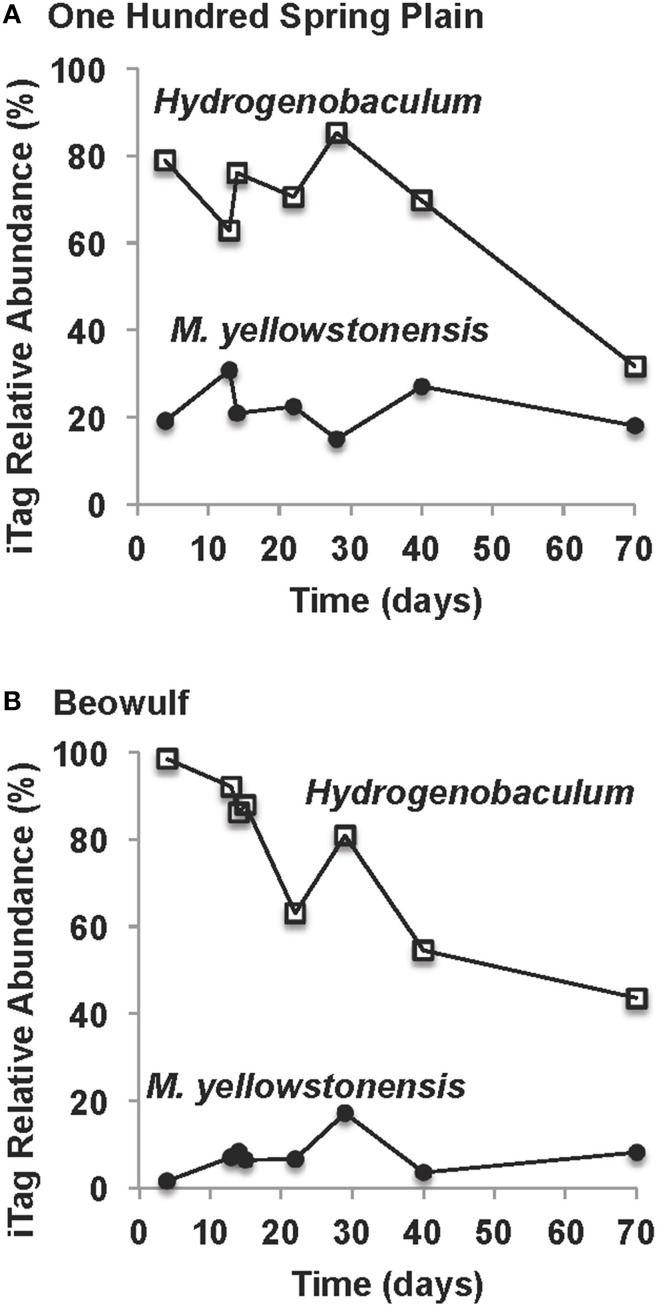
Relative abundance (16S rRNA gene iTags) of key lithoautotrophic microbial populations over the time course of slide incubations in One Hundred Spring Plain (A) and Beowulf (B) Springs (Hydrogenobaculum spp. = open squares; Metallosphaera yellowstonensis = closed black circles).